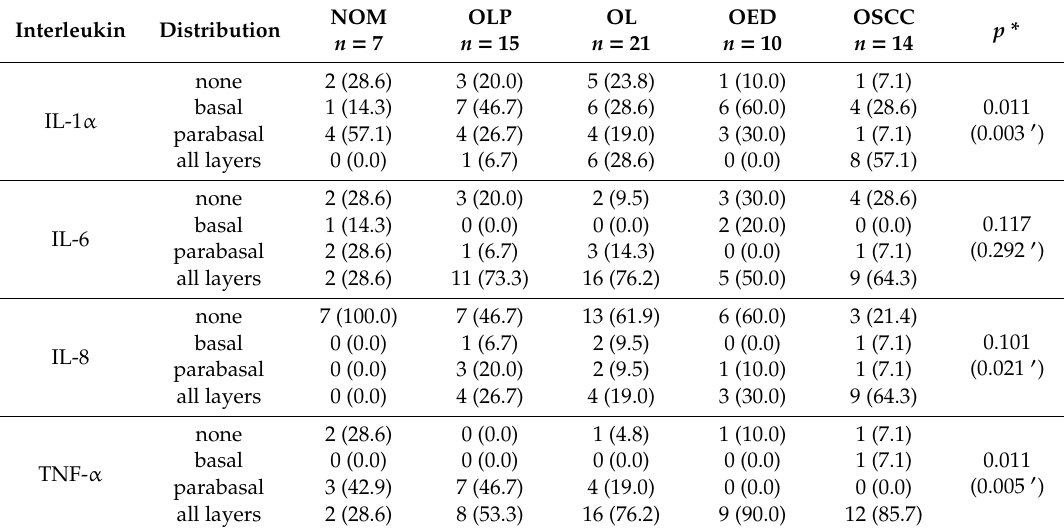
Table 2. Distribution of particular cytokines within the epithelium of